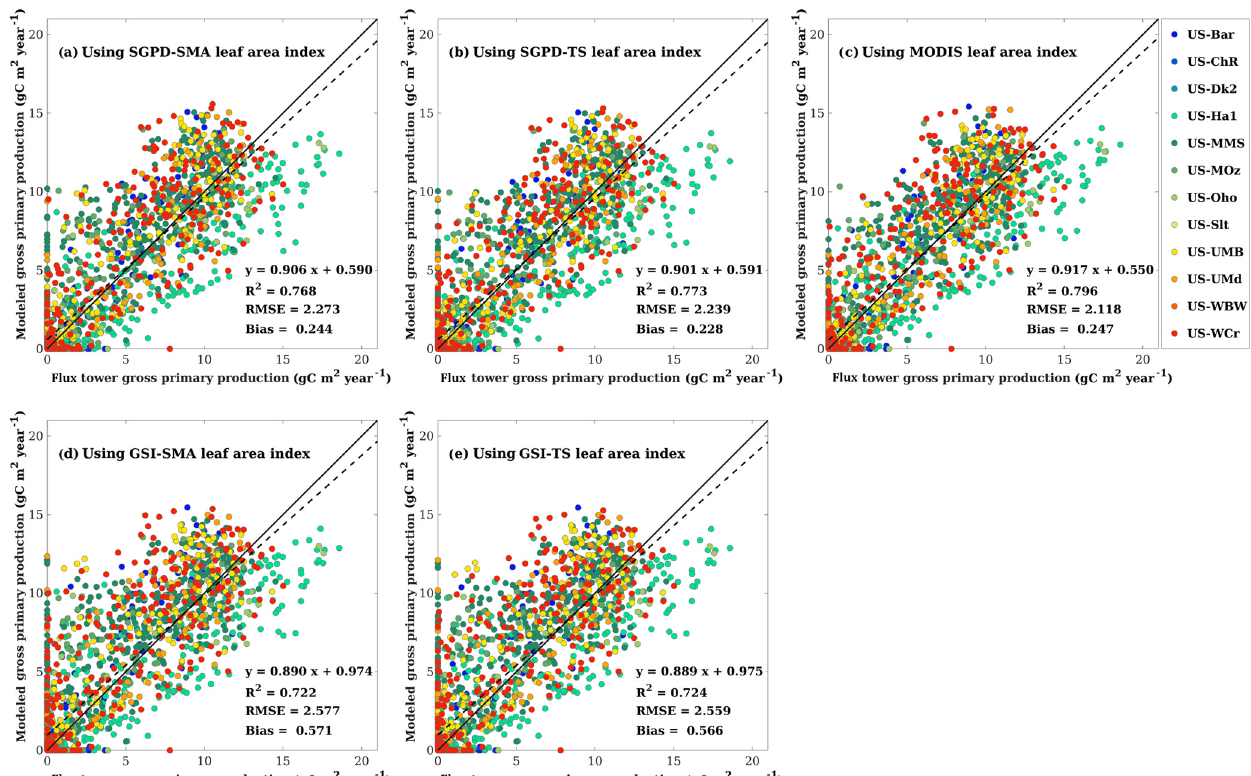
Figure 3. Scatter plots are shown for comparisons (a) between the GPP modeled using SGPD-SMA LAI and the flux tower GPP, (b) between the GPP modeled using SGPD-TS LAI and the flux tower GPP, (c) between the GPP modeled using MODIS LAI and the flux tower GPP, (d) between the GPP modeled using GSI-SMA LAI and the flux tower GPP, and (e) between the GPP modeled using GSI-TS LAI and the flux tower GPP on a weekly basis. All available site-year flux tower data were included in the analysis. All modeled GPP values were derived using the MOD17 algorithm. The solid lines denote the 1:1 lines and the dashed lines denote the regression